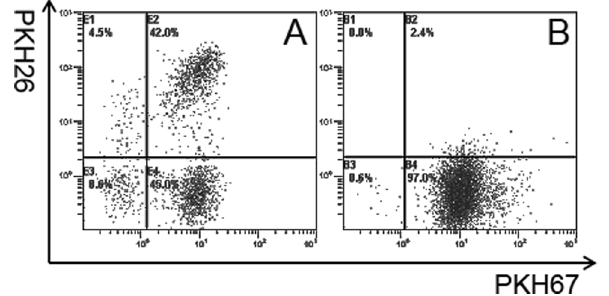
Figure 6. FACS analysis of apoptotic/necrosis tumor cells phagocytosed by DCs. DCs and auto breast tumor cells (from patient 1) were stained red and green by PKH26 and PKH67 and double positive cells were analyzed using FACS and confocal microscopy. A, FACS analysis of the non-adherent cells fraction from the total fusion products. DC phagocytosis of apoptotic tumor cells was calculated as the percentage of double-positive cells, and was approximately 42%. B, FACS analysis of DCs mixed with tumor cells. No significant phagocytosis was observed.